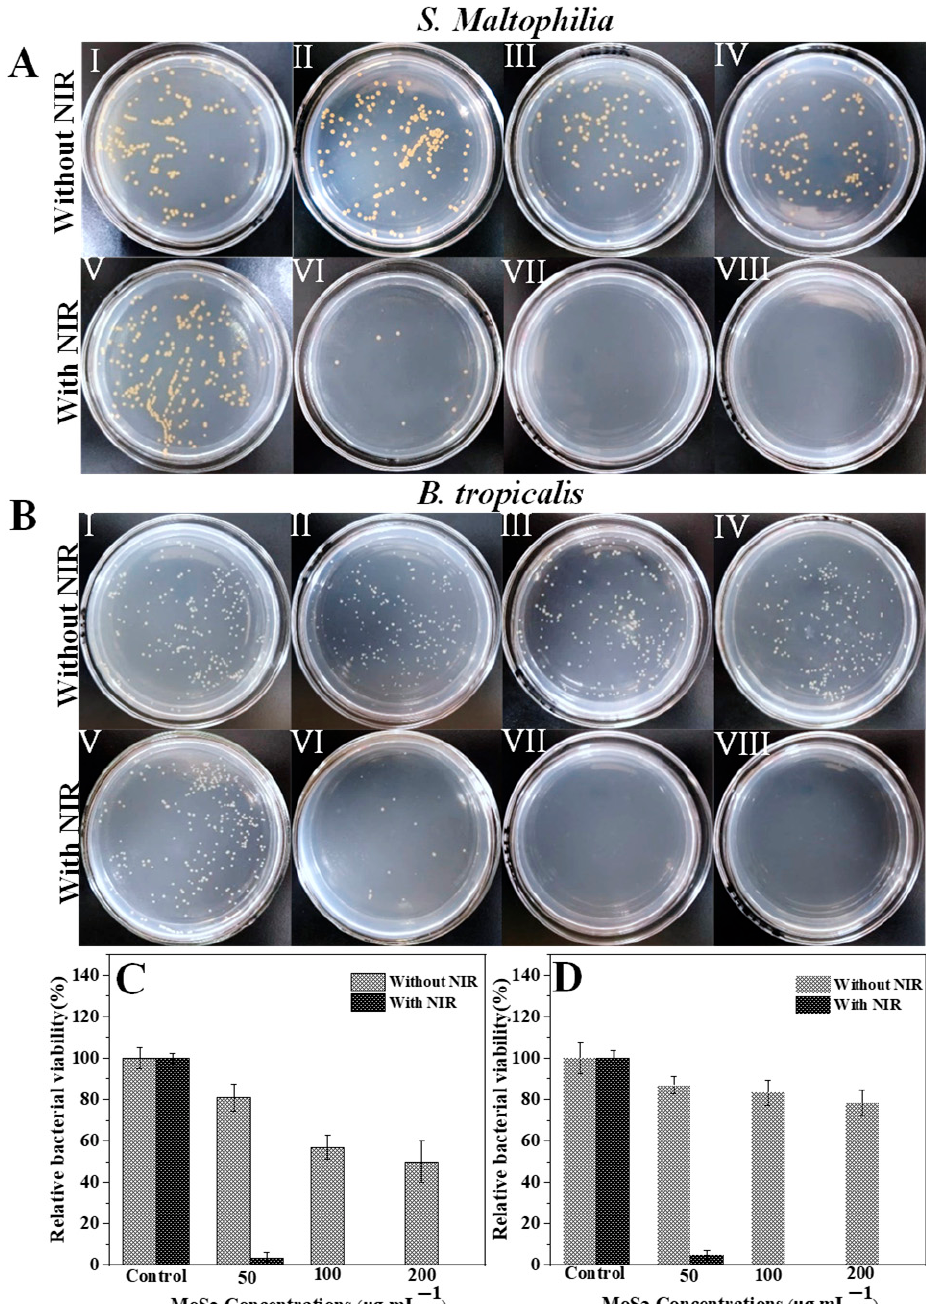
Figure 6. Photographs of bacterial colonies formed by ( A ) S. Maltophilia and ( B ) B. tropicalis after exposed to (I) PBS, (II) 50 µ g/mL PEG-MoS 2 NFs, (III) 100 µ g/mL PEG-MoS 2 NFs, (IV) 200 µ g/mL PEG-MoS 2 NFs, (V) PBS + NIR, (VI) 50 µ g/mL PEG-MoS 2 NFs + NIR, (VII) 100 µ g/mL PEG-MoS 2 NFs + NIR, (VIII) 200 µ g/mL PEG-MoS 2 NFs + NIR; The relative viability of ( C ) S. Maltophilia and ( D ) B. tropicalis after heat treatment with 808 nm NIR light for 10 min was measured by plate counting (Error bars are standard deviations of three parallel experiments).